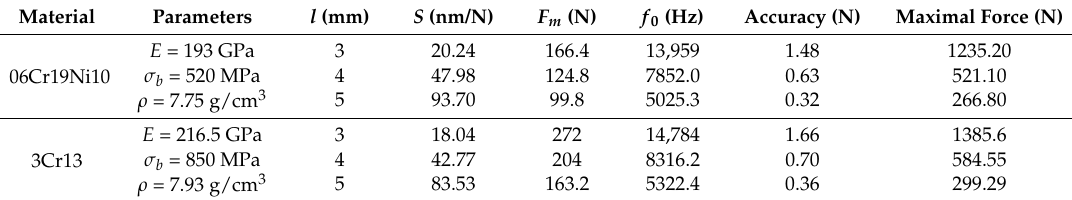
Table 1. The calculation results when the clamped-clamped beams were used with 06Cr19Ni10 and 3Cr13 in different beam length.